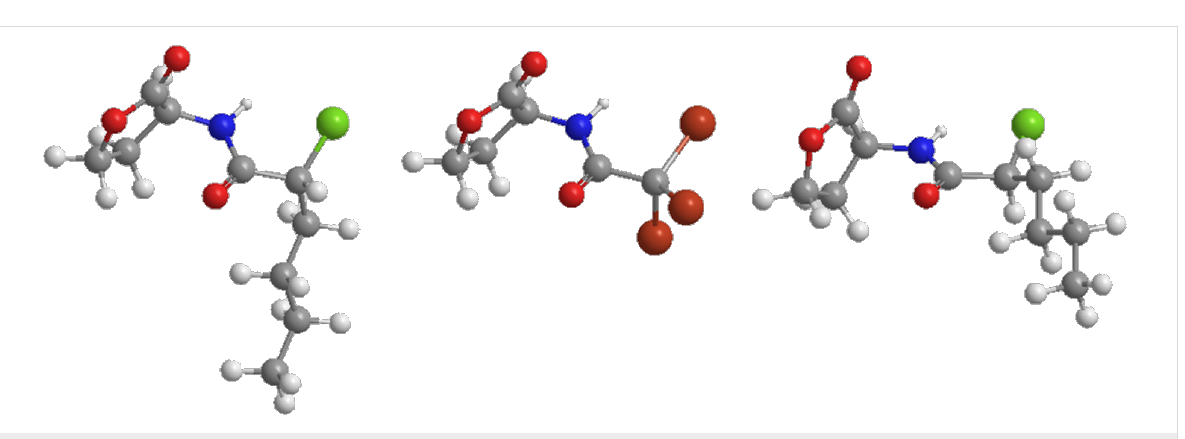
Figure 3: Proposed models (Chem3D Pro) of N -(2 R )- (left) and N -(2 S )-chlorohexanoyl-( S )-homoserine lactone (right) 11a aligned with the optimized structure of N -tribromoacetyl homoserine lactone (middle) [18].